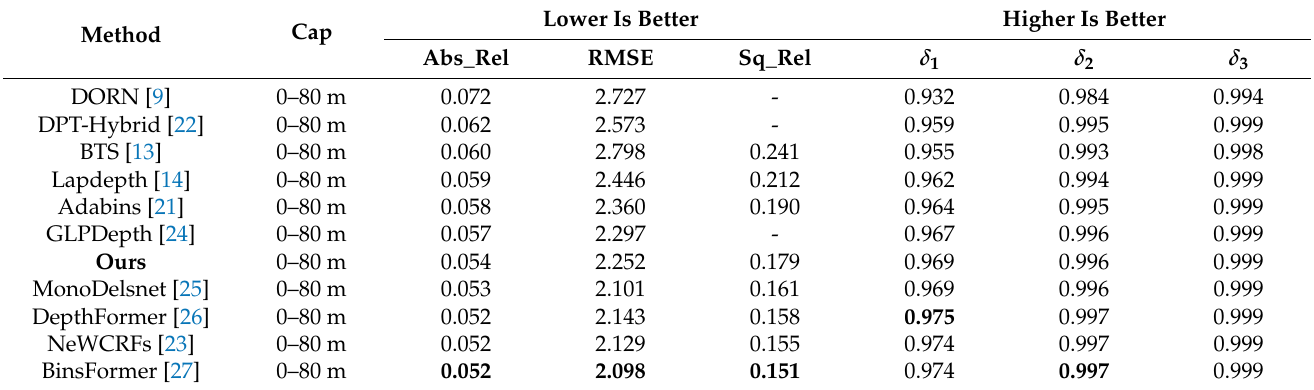
Table 4. Performance comparison using the KITTI Eigen split with the state-of-the-art networks.